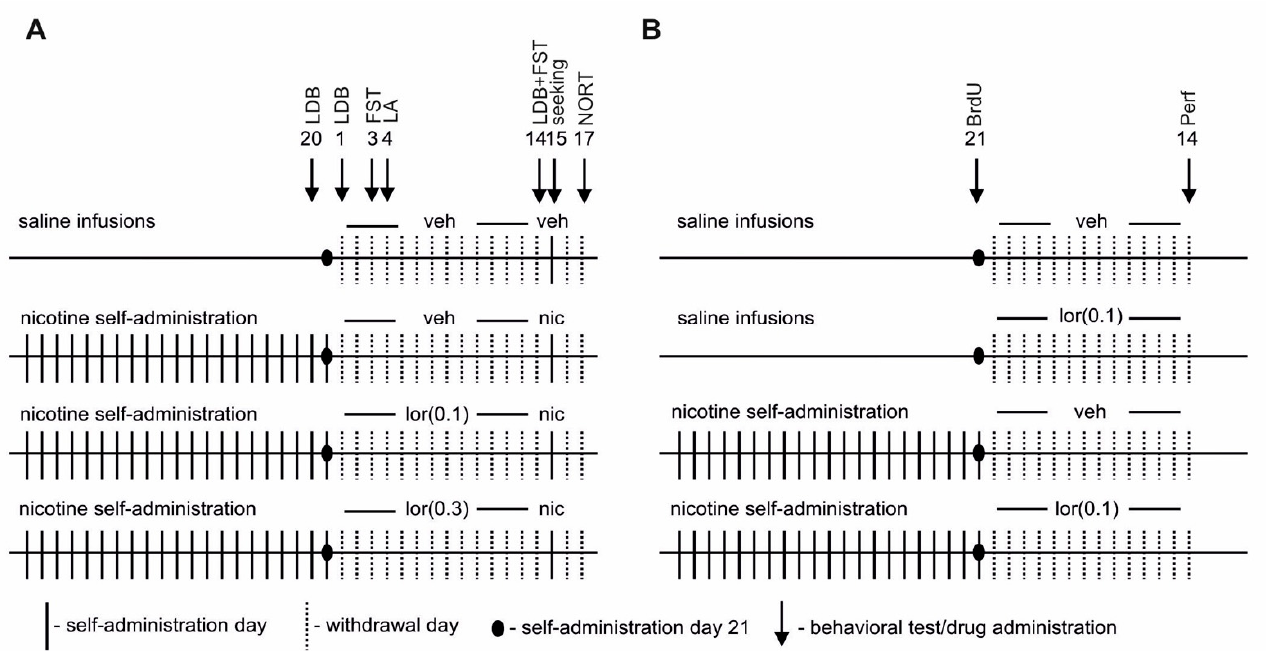
Figure 6. Experimental schedule of nicotine self-administration and behavioral and neurobiochemical analyses performed during nicotine withdrawal. Rats were allowed to self-administer nicotine (0.03 mg/kg/inf, nic) or they received saline infusions (ysal) in 2-h sessions. After 21 sessions, rats entered the withdrawal phase (for 14 days), during which they received daily injections of lorcaserin (0.1–0.3 mg/kg, sc, lor) or a vehicle (veh). ( A ) Effects of lor (0.1–0.3 mg/kg) on the behavioral symptoms of nic withdrawal. The following symptoms of nic withdrawal were measured: anxiety-related behavior in the light/dark box (LDB, the 20th self-administration session; withdrawal day 1 and 14), depression-like behavior in the forced swim test (FST, withdrawal day 3 and 14), basal locomotor activity (LA) (withdrawal day 4), ‘nic-seeking’ behavior (seeking) induced by nic priming (0.4 mg/kg, sc) (withdrawal day 15) and cognition-like deficits in the novel object recognition task (NORT, withdrawal day 17). ( B ) Effects of lor (0.1 mg/kg) on hippocampal neurogenesis during nic withdrawal. Immediately after the last self-administration session, rats were injected with 5-bromo-2’-deoxyuridine (BrdU, 3 × 50 mg/kg, ip) to label proliferating cells. After a 14-day treatment with lor or veh, animals were perfused (Perf), and hippocampal neurogenesis was examined.